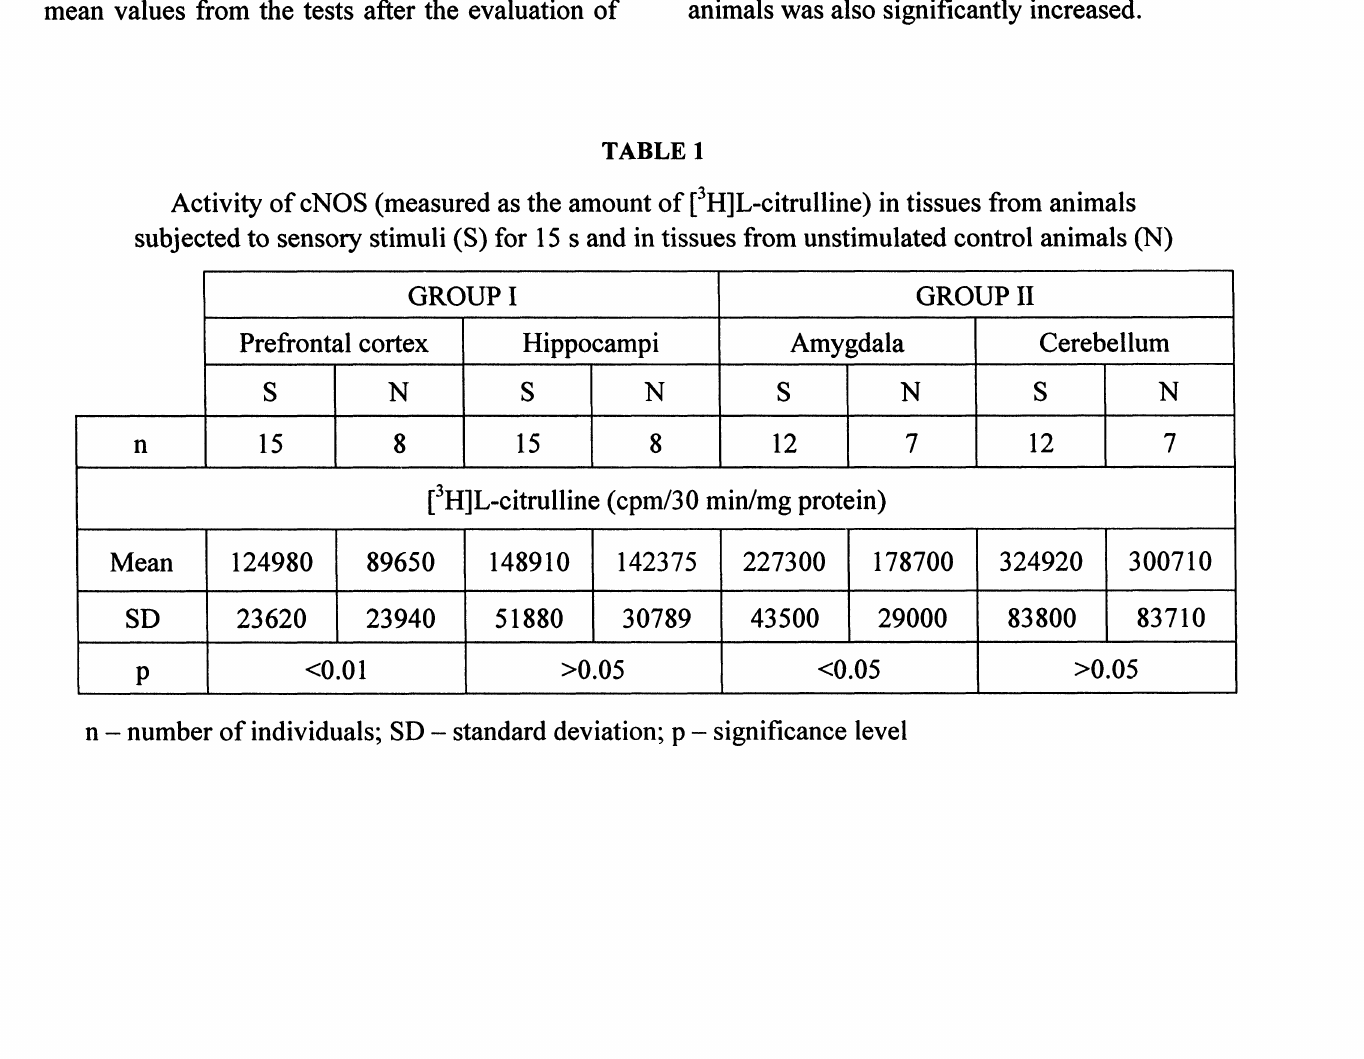
Activity of eNOS (measured as the amount of [3H]L-citrulline) in tissues from animals subjected to sensory stimuli (S) for 15 s and in tissues from unstimulated control animals